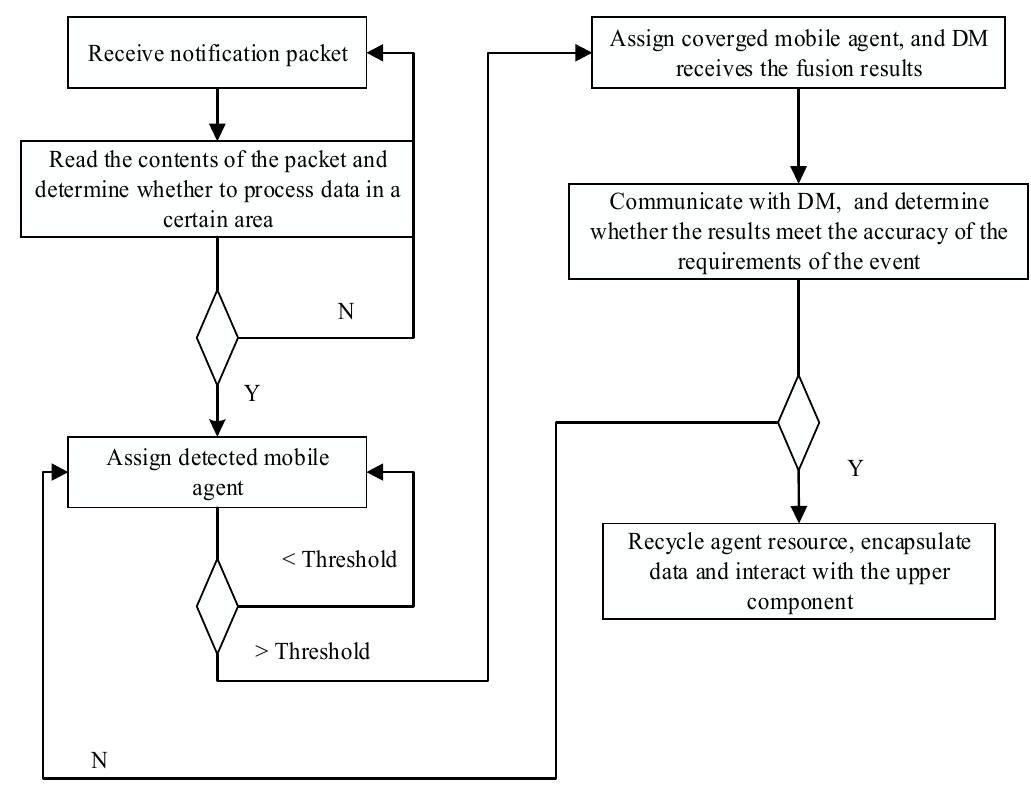
Figure 15. RMS middleware action flow chart.